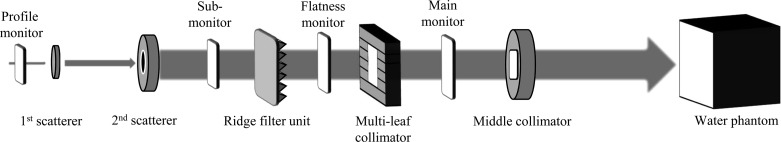
Calculation geometry used for the physical and RBE-weighted dose validation of the clinical proton beam therapy.